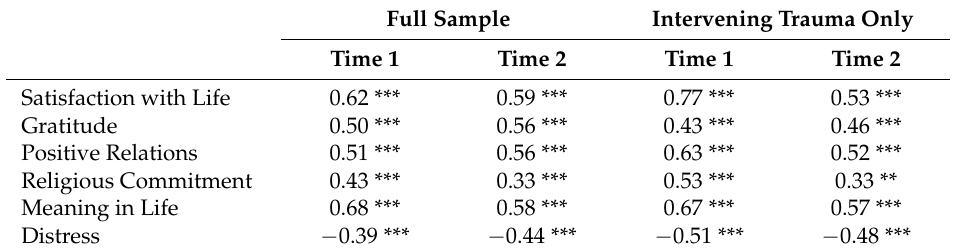
Table 3. Correlations between the C-PTGI, secondary measures of actual PTG, and distress at Time 1 and Time